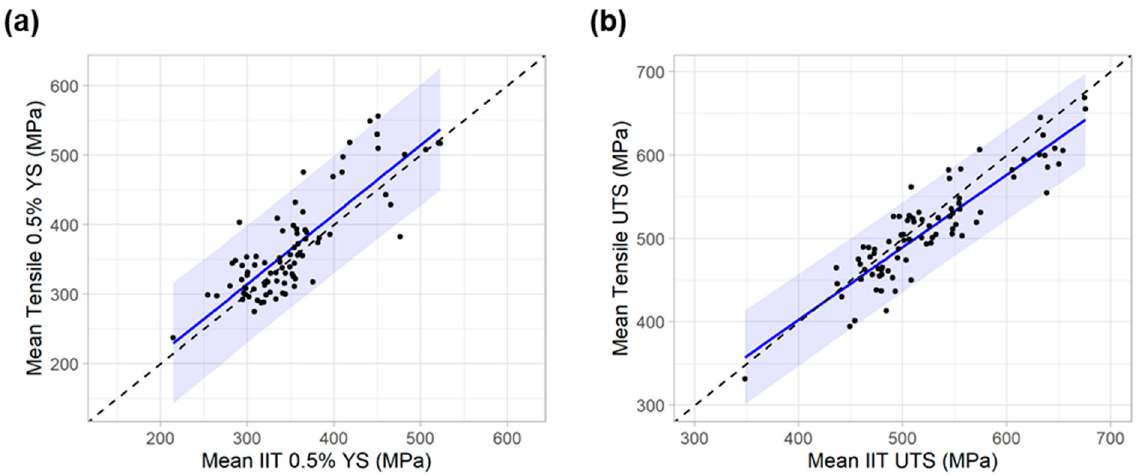
Figure 8. Unity plots comparing mean IIT and tensile measurements on a per-feature basis with linear regression (blue line) and 95% prediction interval (blue shaded region) for ( a ) YS and ( b ) UTS.